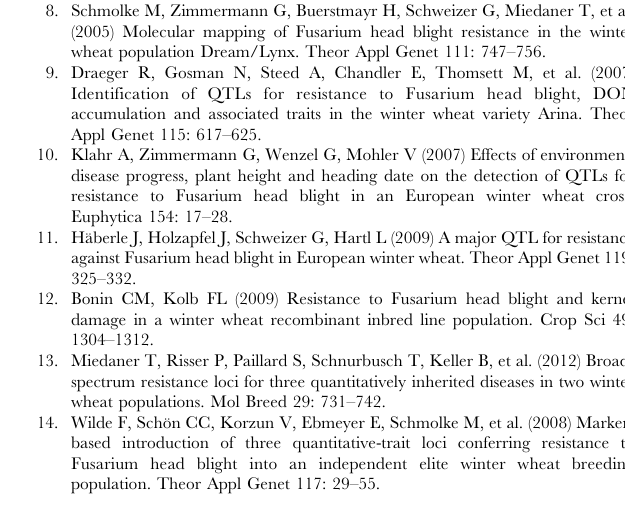
Figure S1 Chromosomal location of marker-trait asso- ciations.